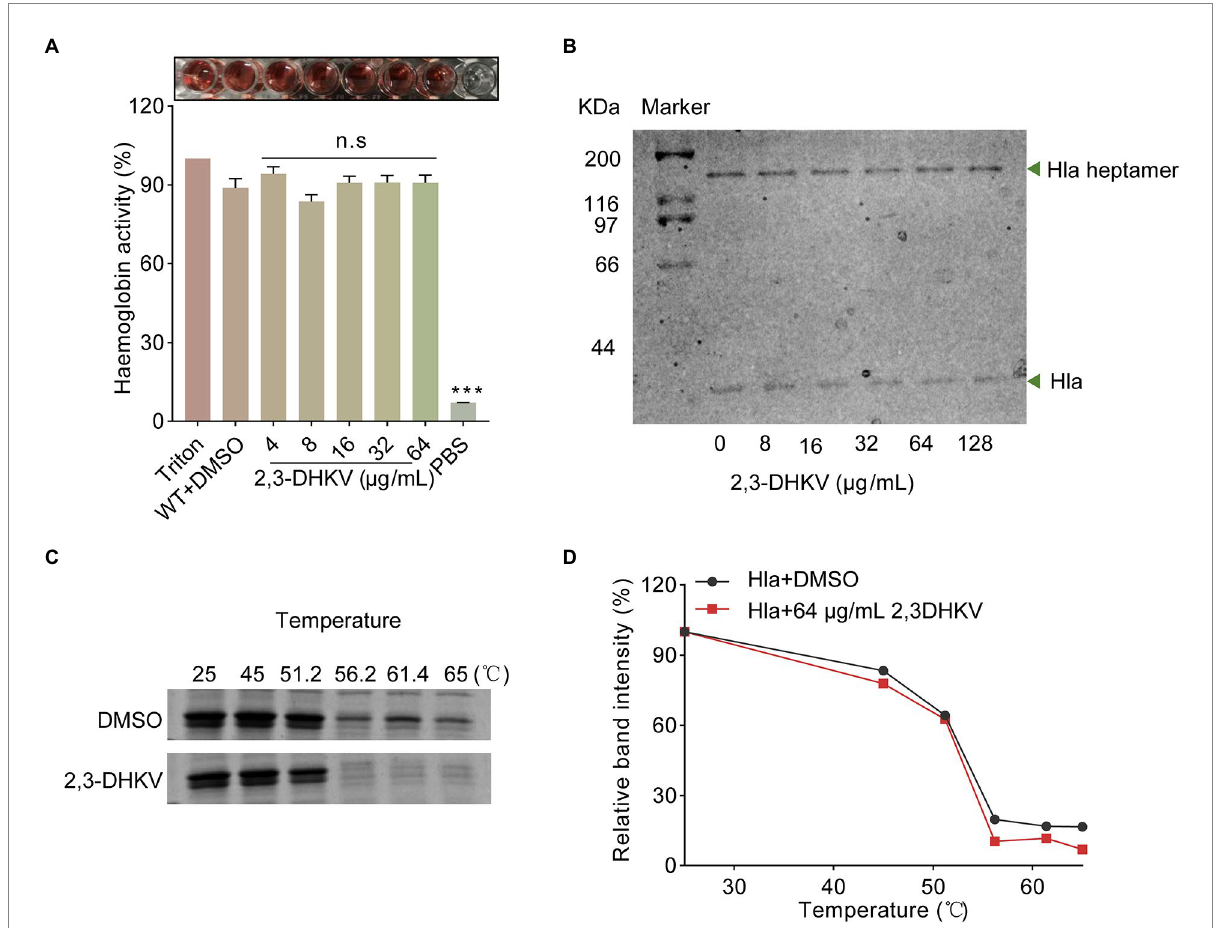
FIGURE 2 2,3-DHKV does not affect the heptamer formation of Hla in S. aureus. (A) The effect of 2,3-DHKV on the neutralization activity of Hla. (B) The heptamer formation assay of Hla treated or non-treated with 2,3-DHKV. (C,D) CETSA analysis was performed to analyze the direct interaction between 2,3-DHKV (64 μ g/ml) and